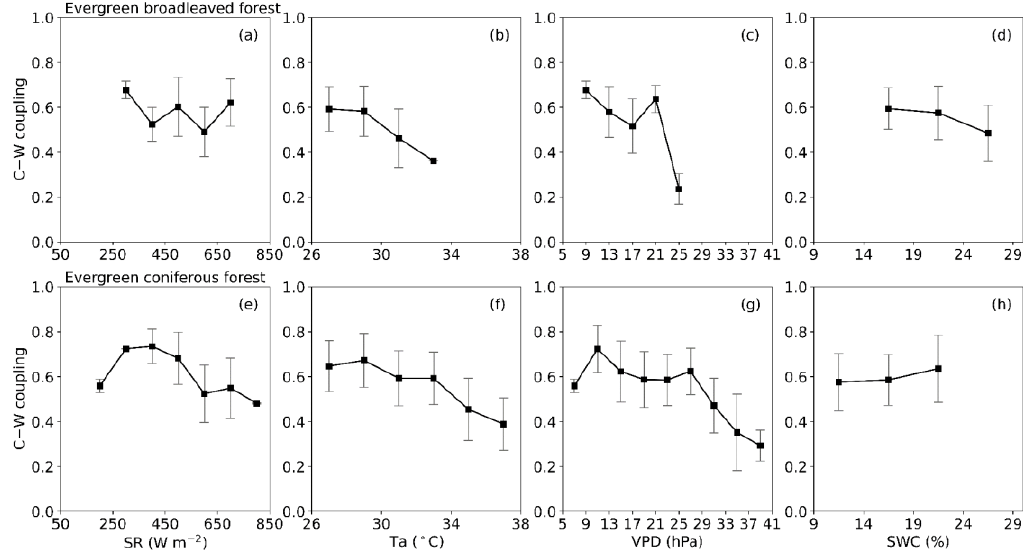
Figure 7. Diurnal C–W coupling varying with meteorological conditions (SR, T a , VPD, and SWC) in the broadleaved forest at Dinghushan ( a – d ) and in the coniferous forest at Qianyanzhou ( e – h ), where ( a , c ) are WUE dt variations with SR, ( b , f ) are for T a , ( c , g ) are for VPD, ( d , h ) are for SWC. The means and standard deviations of C–W coupling varying with meteorological conditions are marked with dots and error bars, respectively.